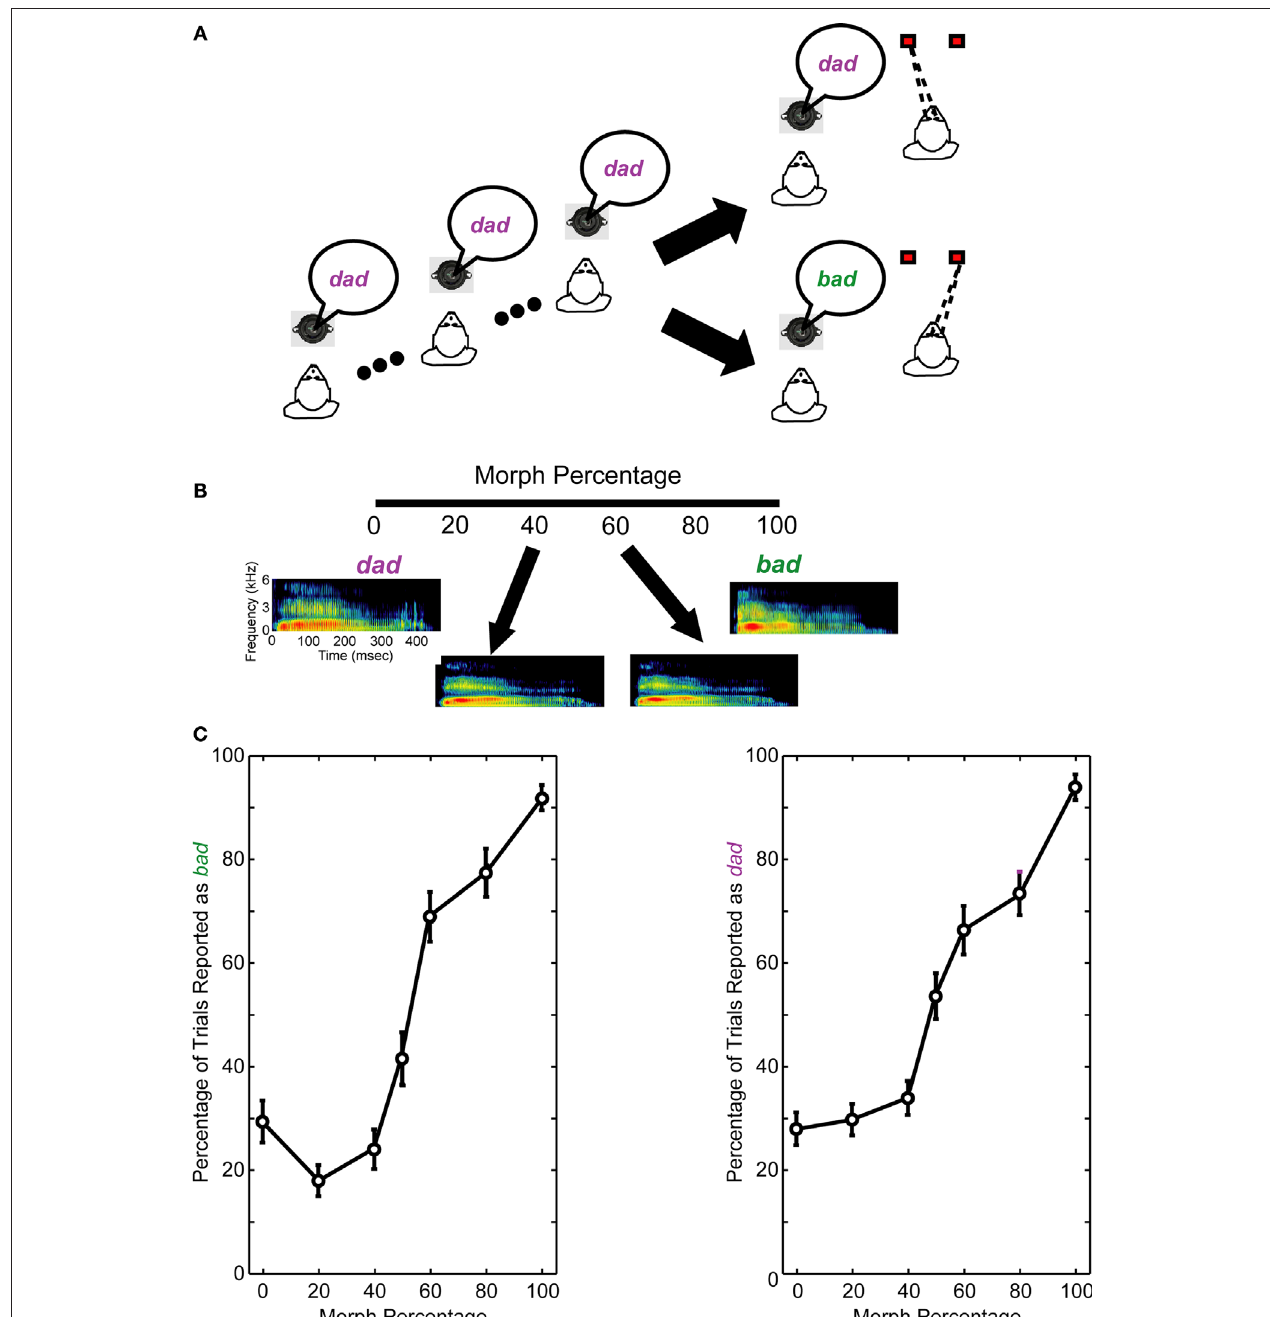
dad , the morph percentages are reversed (e.g., the 0% morph is bad and the 100% morph is dad ). The axes for all of the spectrograms are seen in the leftmost spectrogram. (C) The average performance of the monkeys from those recording sessions reported in this manuscript. The monkeys’ performance is shown as a function of the reference stimulus: the prototype spoken word bad (left column) or dad (right column) . A 0% morph means that the test stimulus was a different prototype than the reference stimulus (e.g., the reference stimulus was the prototype bad and the test stimulus was the prototype dad ). A 100% morph means that the test and reference stimuli were the same (e.g., both were the prototype dad ). Other values represent morphed stimuli between these two extremes. Error bars are standard error of the